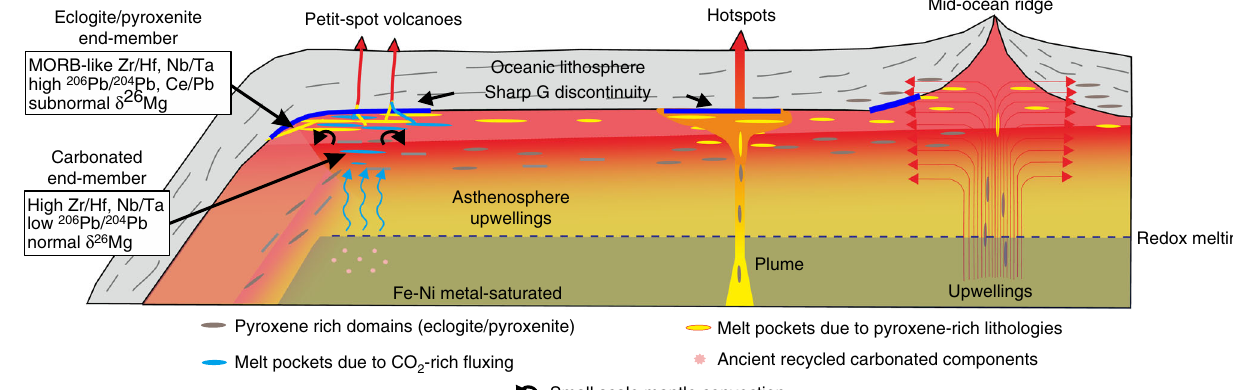
Fig. 5 Schematic cross-section of the oceanic mantle illustrating potential mechanisms that could concentrate partial melts below the oceanic LAB. The G discontinuity (bold dark blue lines) corresponds to the melt layer enhanced by the stagnation of partial melt at the base of the lithosphere. The dark gray lenses show pyroxene-rich heterogeneities due to recycling of ancient crustal materials. They will develop melt pockets in the shallow LVZ (yellow lenses) due to different scale of upwelling of the asthenosphere at ridges, hotspots or near the subduction zone 4 , and stretched horizontally due to the mantle fl ow 11 . Beneath the old oceanic lithosphere where petit-spot basalts erupted, two end-members of recycled components (recycled carbonated marine sediments and the recycled oceanic eclogite/pyroxenite) contribute to the formation of partial melts that fi nally generate melt layers beneath the LAB and cause the origin of the G discontinuity. See the text for the details of the